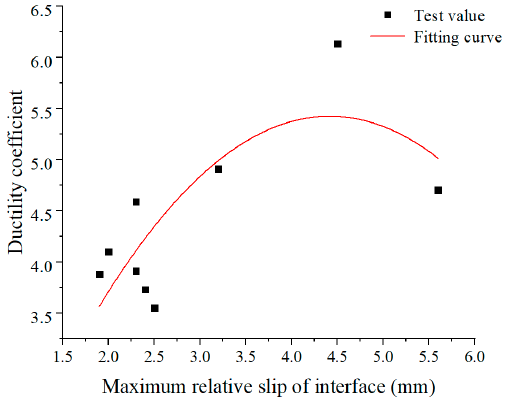
Figure 16. The ductility coefficient vs. the maximum slip curve of interface.